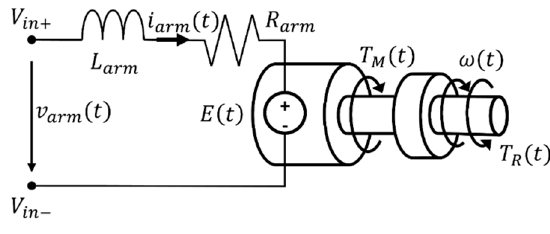
Figure 4. DC motor model. Figure 4. DC motor